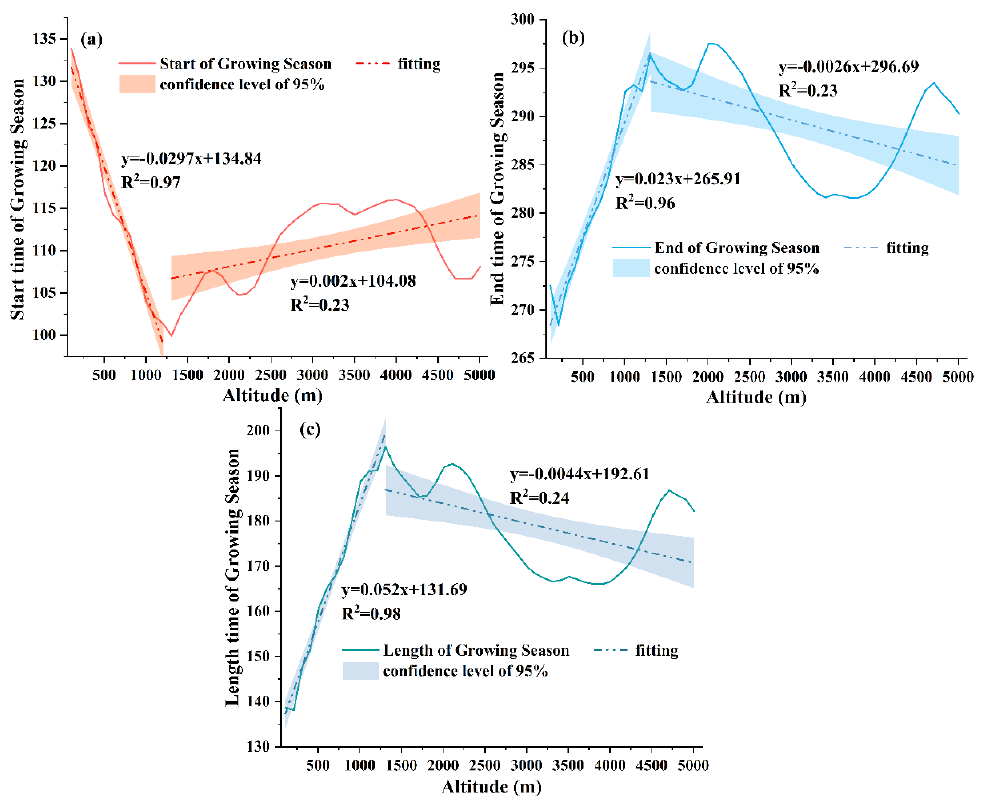
Figure 4. Characteristics of the vegetation phenology with altitude change. ( a – c ) indicate the aver ‐ age changes in the SOS ( a ), EOS ( b ), and LOS ( c ) at different altitudes, from 2000 to 2020, respec ‐ tively.